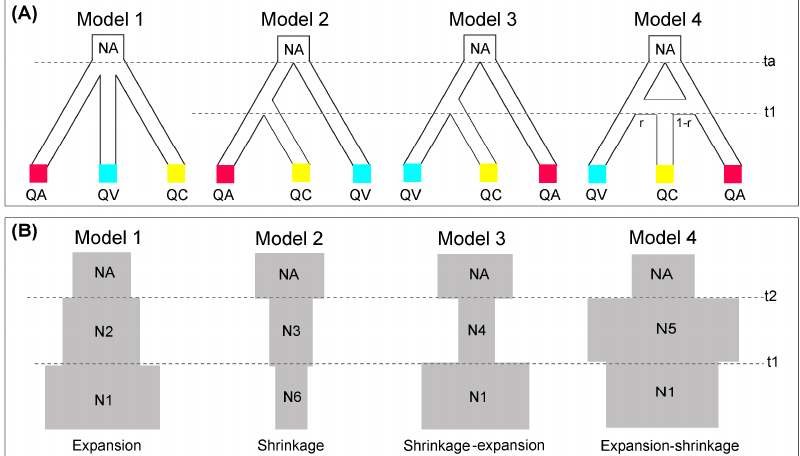
Figure 2. The four models for the species demographical history of the three oak species ( Q. variabilis , Q. chenii and Q. acutissima ) in DIYABC ( A ). The four tested historical demographic models proposed for the populations of the three Cerris oaks ( B ).